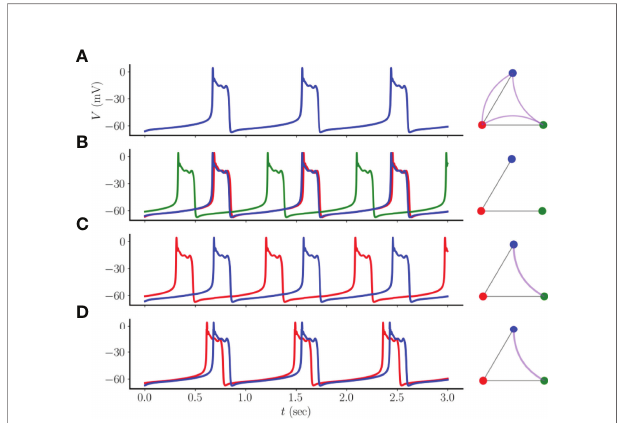
FIGURE 4 | Four asymptotic states that can arise from a three-node network consisting of a center cell (red node) coupled to two satellite cells (blue and green). (A) A homogeneous state in which bursting is perfectly synchronized across all cells. In the network graph on the right, straight edges indicate electrical or structural coupling, while curved edges indicate synchrony or functional coupling. The functional network graph is complete. (B) The center cell is nearly synchronized with a satellite, while the other satellite is far out of phase. There are no edges in the functional network. (C) The two satellite cells are synchronized, while the center cell is far out of phase. The single edge in the functional network is not an edge in the structural network. (D) Similar to the previous panel, but bursting in the center cell largely overlaps that of the satellites. The coupling conductance is g c =2 pS.